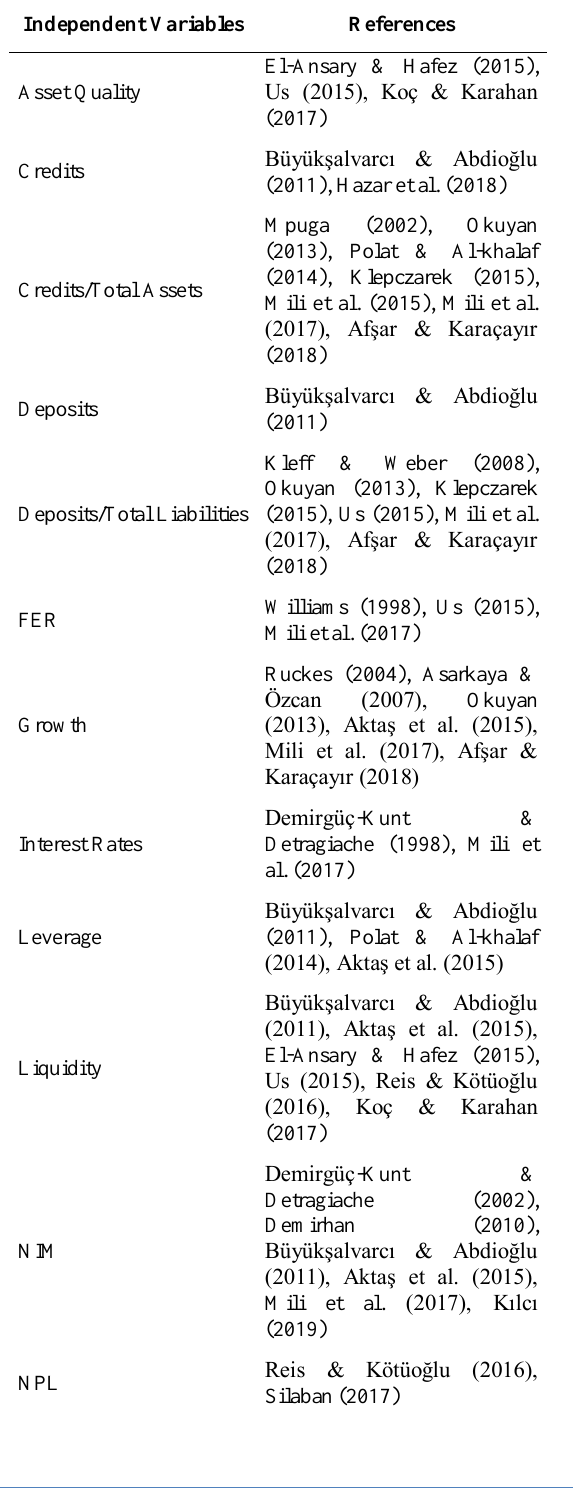
Table 1: Independent Variables Independent